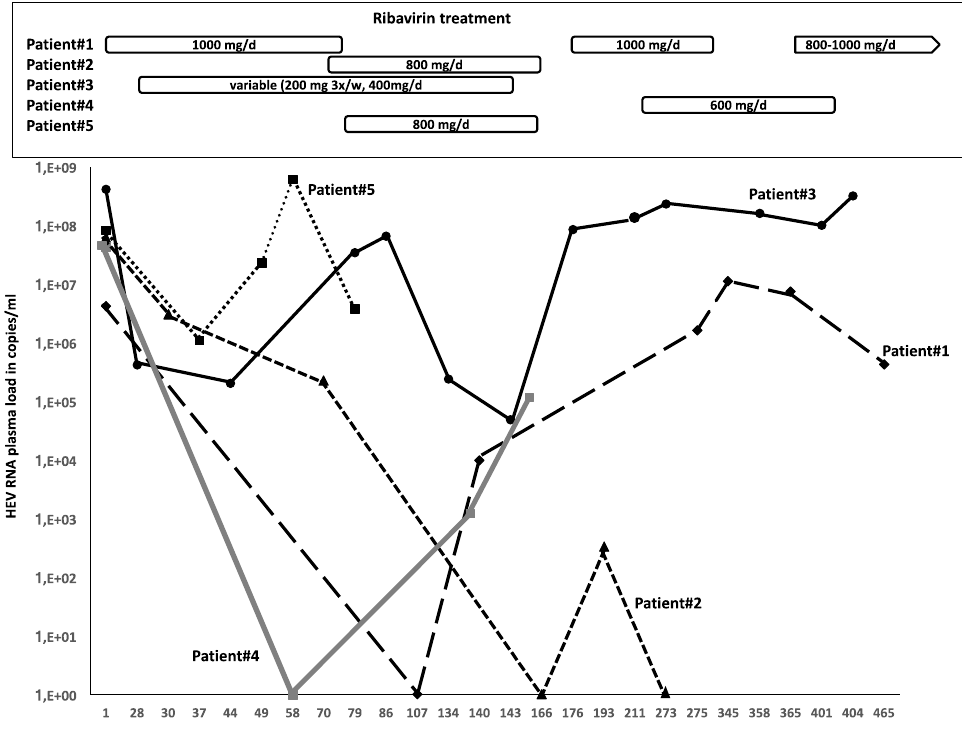
Figure 1. HEV load under ribavirin (RBV) treatment.